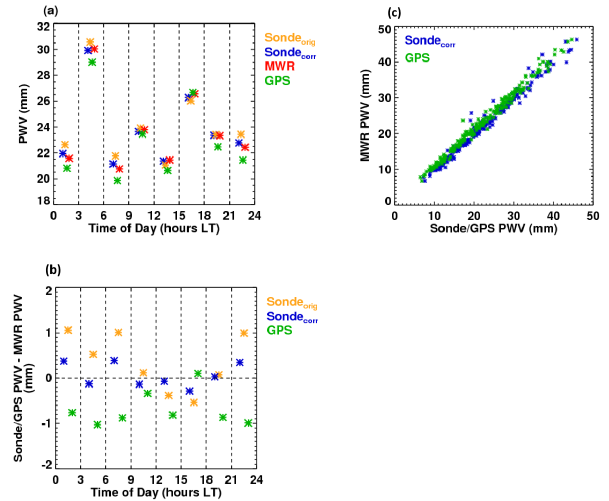
Figure 5. Diurnal variation of PWV at site C1. (a) Retrieved from an uncorrected sounding profile (yellow), a corrected sounding (blue), MWR observations (red) and GPS observations (green) av- eraged over all sondes in 3h time windows; (b) absolute differences between retrieved PWV estimates; (c) scatterplot of retrieved PWV from corrected radiosonde profiles and GPS.